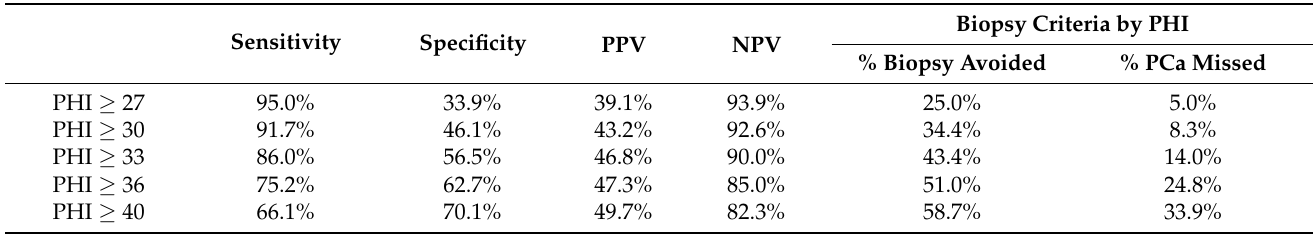
Table 3. Diagnostic performance for overall and clinically significant prostate cancer detection via different PHI